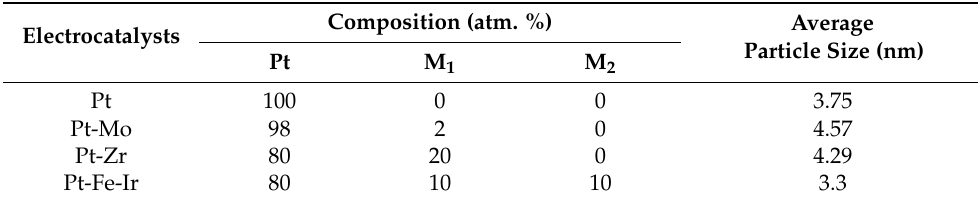
Figure 1. TEM images of the ( a ) Pt/C; ( b ) Pt-Mo/C; ( c ) Pt-Zr/C; and ( d ) Pt-Fe-Ir/C electrocatalysts. Table 1. Composition and particle size for the Pt, Pt-Mo, Pt-Zr, and Pt-Fe-Ir electrocatalysts on carbon black support.